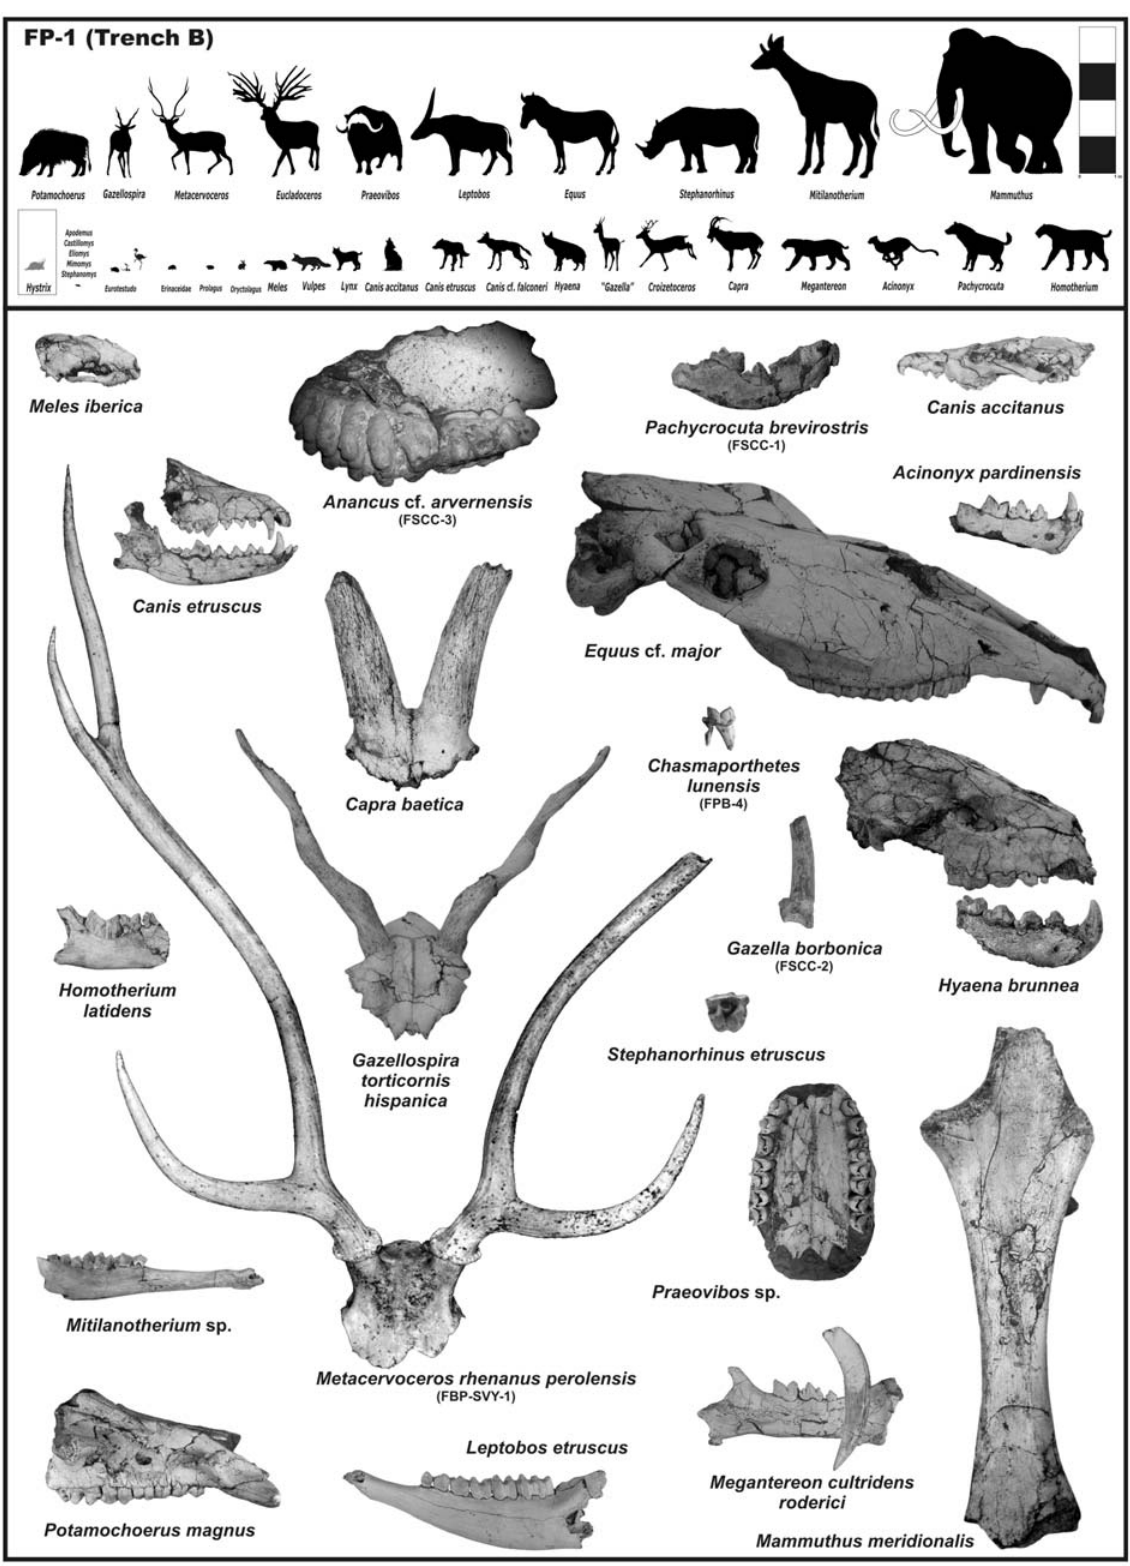
Figure 5. Top: faunal diversity of FP-1 (Trench B). Silhouettes (to scale) of the mammals identified in the deposit (taxonomic discussion in 29, 30, 32, 33). In grey: the taxa (unpublished) identified from indirect taphonomic evidence, as Hystrix . Bottom: several fossil specimens (not to scale) of interest from taxonomic, biostratigraphic or palaeobiogeographic points of view, both in FP-1 and other sites located in the work zone since 2001 (see Figs. S1 and S4).